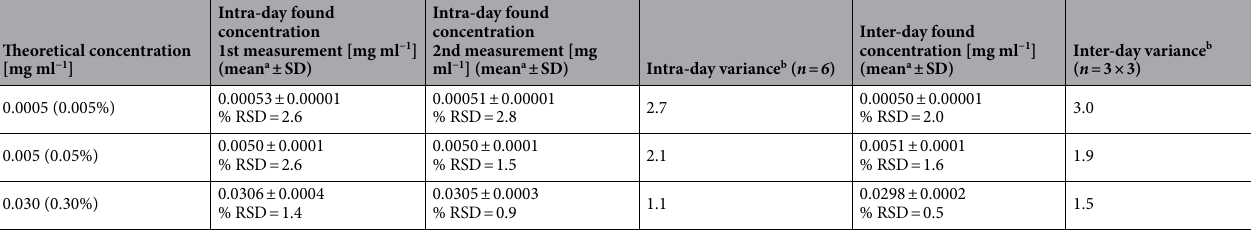
Table 4. Precision values. a Mean value of three independent determinations. b Each value shows %RSD.